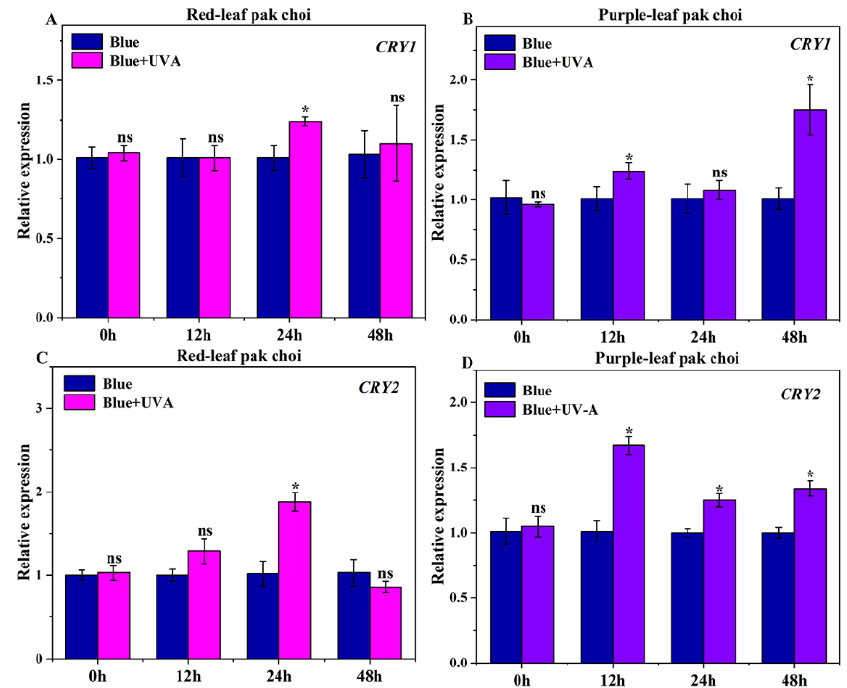
Figure 7. qRT-PCR analysis results of cryptochrome 1 ( CRY1 ) ( A , B ) and cryptochrome 2 ( CRY2 ) ( C , D ) in red- and purple-leaf pak choi. Detection of qRT-PCR analysis at four time points under blue and blue + UVA continuous illumination for 48 h. ‘ns’ means non-significant and ‘*’ represents statistically significant differences ( p < 0.05). Error bars indicate ± SE ( n = 3).